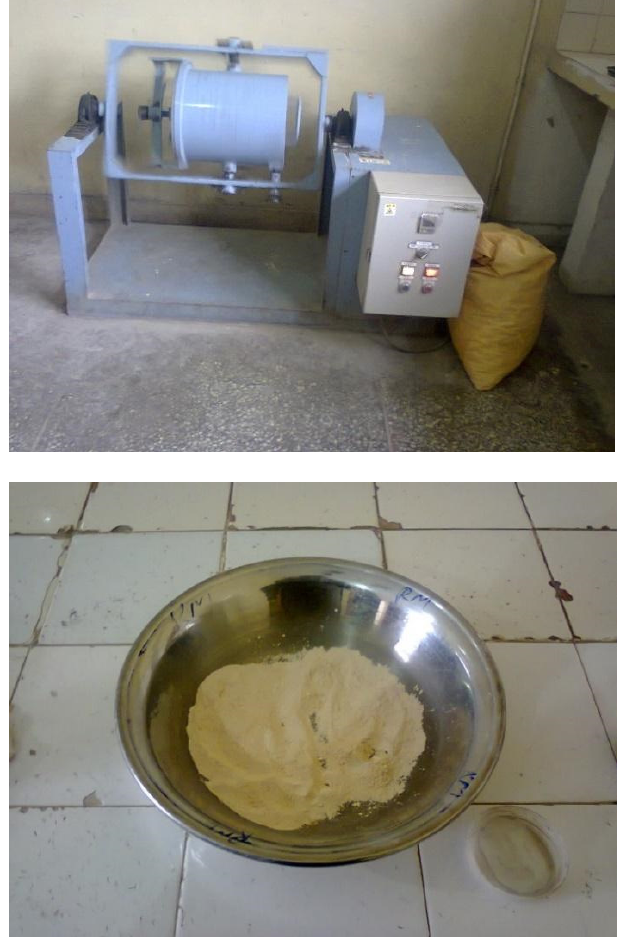
Figure 2. MK in ground form.